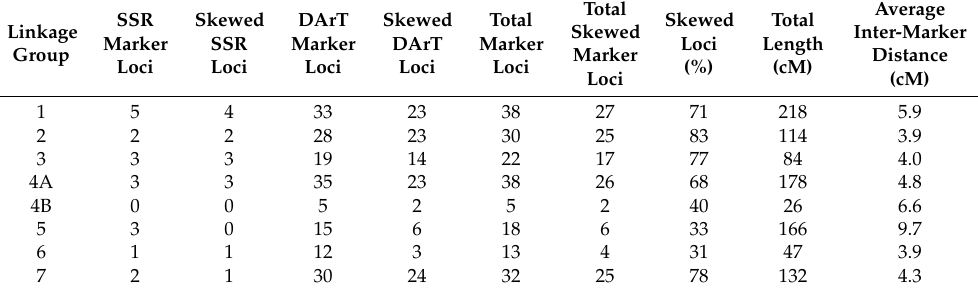
Details of the diversity array technology (DArT)- and simple sequence repeats (SSRs)-based genetic map of the pearl millet RIL population based on the cross ICMS 8511-deriv ×